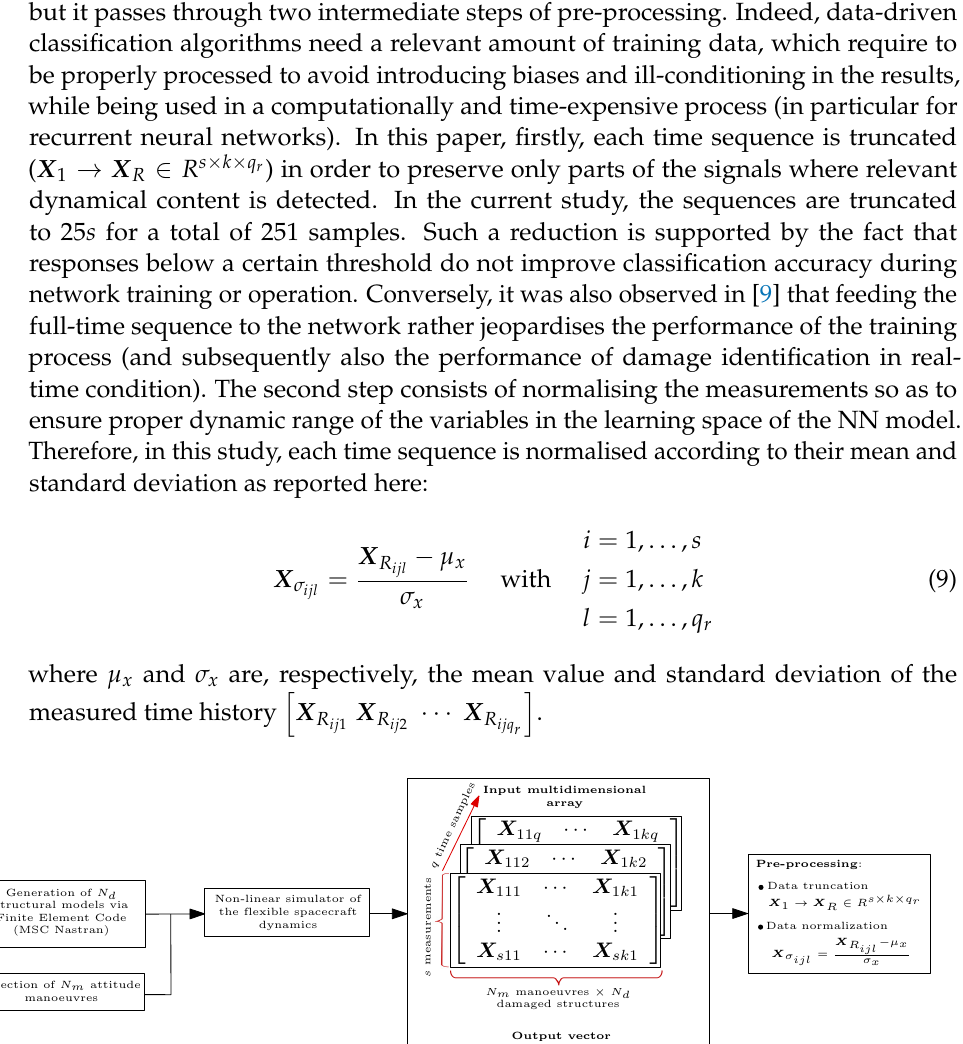
normalised 36-sensor time series associated with one observation having class label “0” (undamaged system). The picture aims at pointing out that the most relevant dynamic content of the acceleration time sequences is detected in the first-time instants of the manoeuvre. Indeed, after the rotation of the satellite has occurred, the residual naturally damped oscillations fade out and the system returns to a stationary condition while the measurements go to zero. Therefore, the time histories have been cut to avoid including in the dataset the components (equal to zero or under a certain threshold) which would contribute to flatten the dataset. The final dataset used for the training consists of an input multidimensional array X R of size 36 × 3003 × 251 while the output vector contains the labels of the failures reported in Table 3 and it has dimensions equal to 3003 × 1, where each simulation is associated with the label of the corresponding